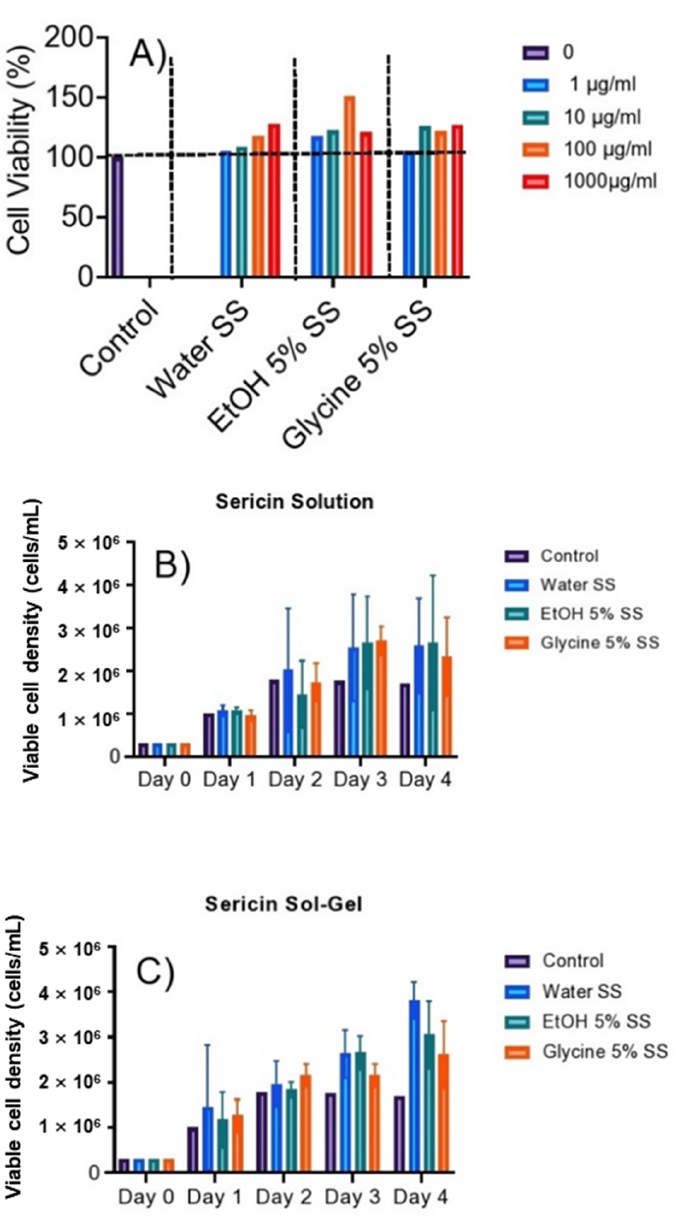
Figure 11. Viability and proliferation of SS affect SS protein. ( A ) Cytotoxicity of SS extract on RAW 264.7 cells using various extraction ingredients. ( B ) RAW 264.7 cell growth in SS solution derived from various stabilizers. ( C ) RAW 264.7 cell proliferation in SS gels derived from various stabilizer agents.